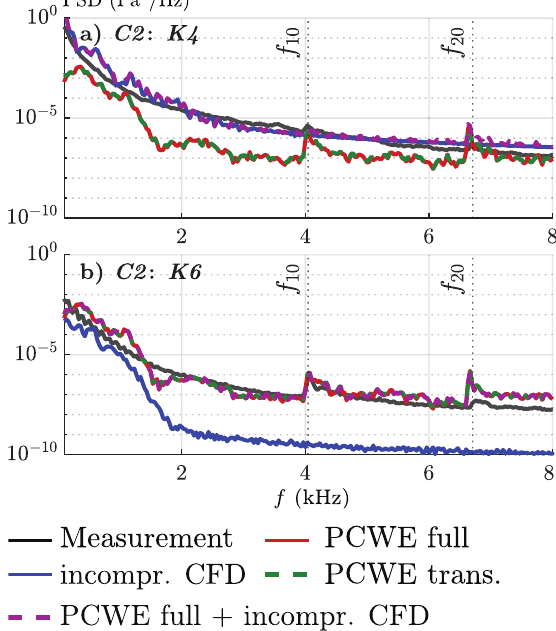
Figure 17. PSDs of the wall pressures for case C 2 at positions K 4 and K 6 downstream of the ori fi ce. Table 4. Overview of deviation of simulations from